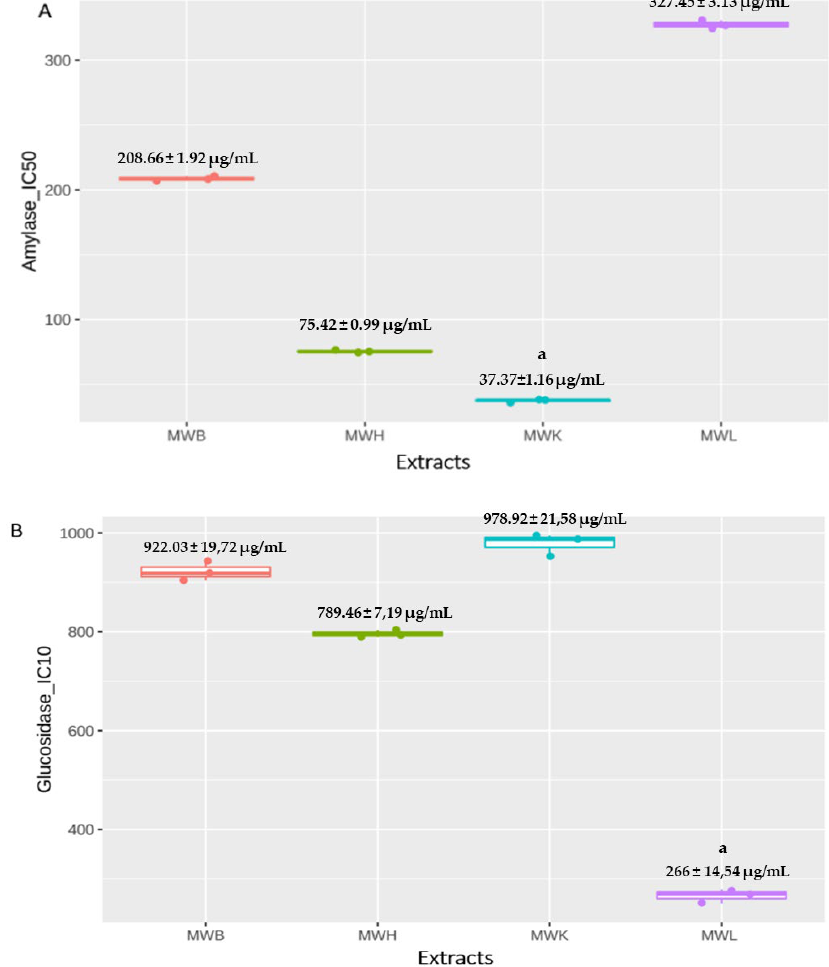
Figure 4. Effect of J. regia methanolic extracts on ( A ) α -amylase and on ( B ) α -glucosidase enzymatic activities. a p < 0.05, Data expressed as mean ± SD. Abbreviations—MWB: Methanolic Extract of bark, MWH: Methanolic extract of Husk, MWK: Methanolic Extract of Kernels, MWL: Methanolic Extract of Leaves.